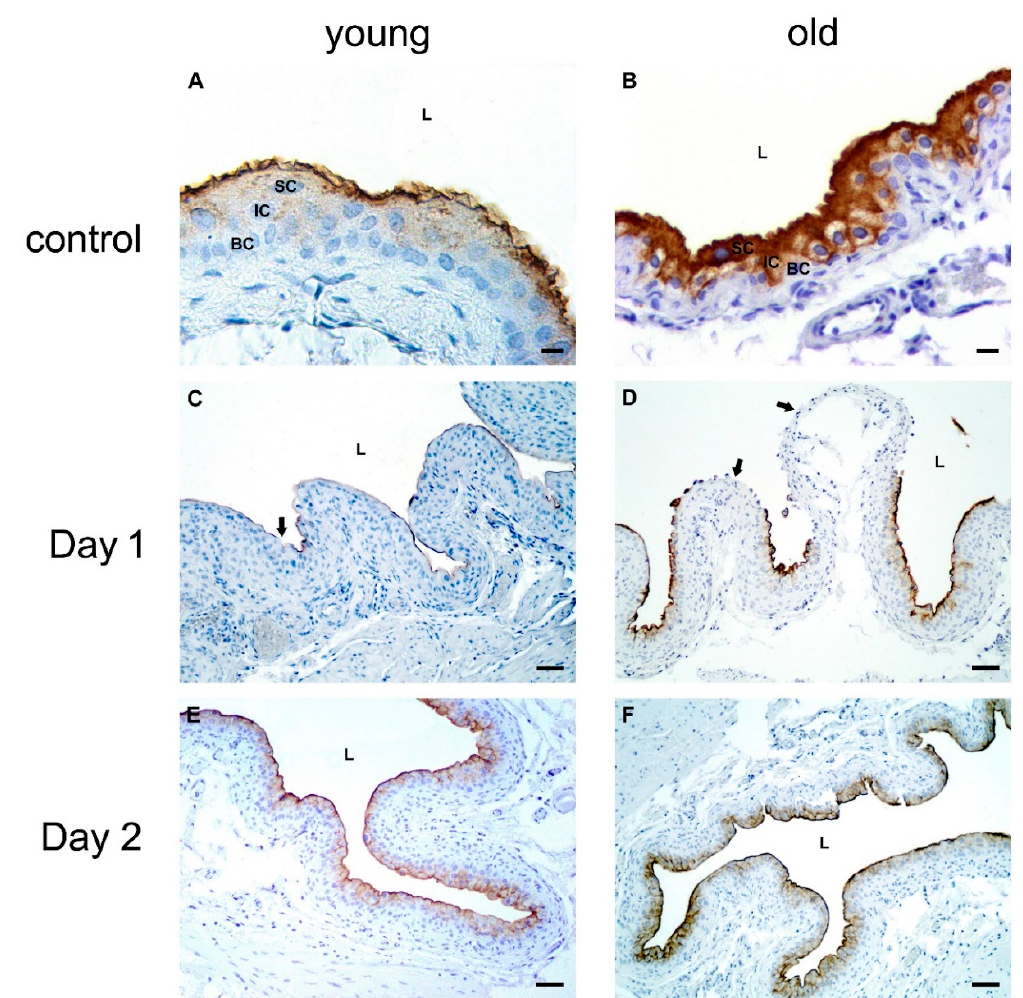
Figure 6. Representative micrographs of immunohistochemical detection of uroplakins in the urothelium of young ( A , C , E ) and old ( B , D , F ) mice. In the urothelium of control young ( A ) and old ( B ) mice, all superficial cells (SCs) show intense positive anti-uroplakin immunoreaction (brown colour) in their apical plasma membrane and apical cytoplasm. On day 1 after chitosan treatment, uroplakins are expressed weakly in new superficial urothelial cells of young and old mice ( C , D ), while in some denuded areas of the urothelium, no uroplakin expression is present (arrows). On day 2 after chitosan treatment, all superficial urothelial cells express uroplakins ( E , F ). Cell nuclei are stained blue with hematoxylin. L-lumen of the urinary bladder. IC-intermediate cells, BC-basal cells. Scale bars: 10 µm ( A , B ); 100 µm ( C – F ).